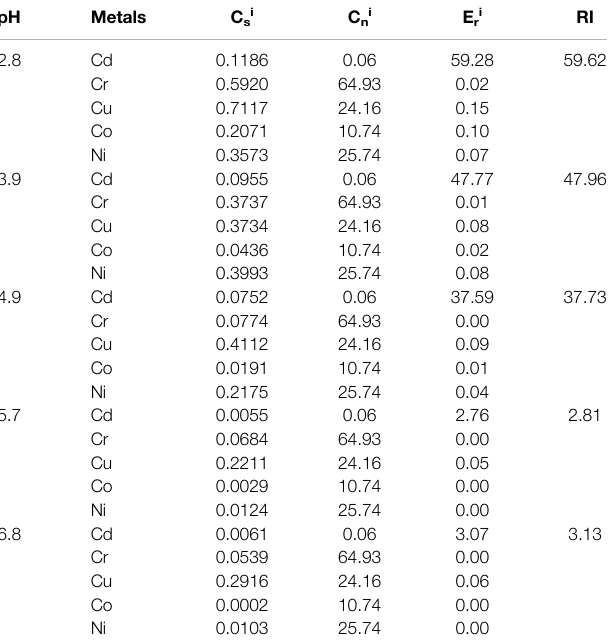
TABLE 6 | Hakanson potential ecological riskindex under different pH